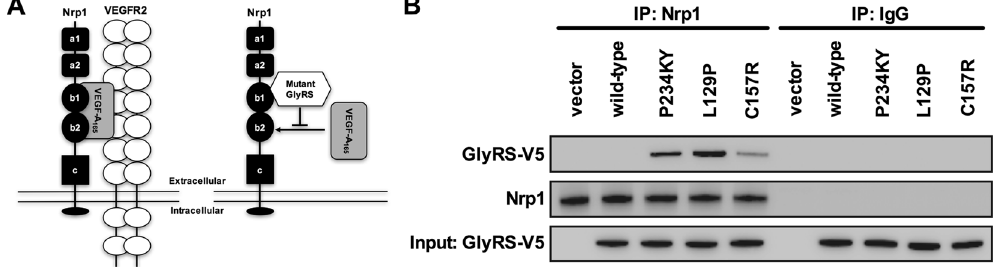
Figure 1. Mutant GlyRS aberrantly binds to the transmembrane receptor neuropilin 1. ( A ) Schematic of Nrp1 and one of its principal co-receptors, VEGFR2, which together bind to the secreted glycoprotein VEGF-A 165 (on the left) 11 . VEGF-A functions in vasculogenesis, angiogenesis, and arteriogenesis, with the latter two processes occurring through Nrp1 and VEGFR2 signalling 17, 18 . VEGF-A is also critical for nervous system development and maintenance 15 . VEGF-A 165 binding to Nrp1 is mainly dependent by the b1 domain 12 . CMT2D-associated mutations in GARS cause a conformational opening of GlyRS, allowing the aberrant binding of mutant GlyRS to the b1 domain of Nrp1 (on the right) 10 . This competitively antagonises Nrp1/VEGF-A signalling, which contributes to motor deficits observed in CMT2D mice 10 . Schematics are not drawn to scale and adapted from Plein et al . 18 and He et al . 10 . ( B ) Co-immunoprecipitation of endogenous Nrp1 showing aberrant interaction with P234KY, L129P, and C157R GlyRS (ectopically expressed with a V5-tag) in NSC-34 cells. Wild-type GlyRS shows no significant binding to Nrp1. The aberrant interaction is weaker with C157R than with P234KY GlyRS, which correlates with the severity of CMT phenotypes in Gars C201R / + and Gars Nmf249 / + mice,